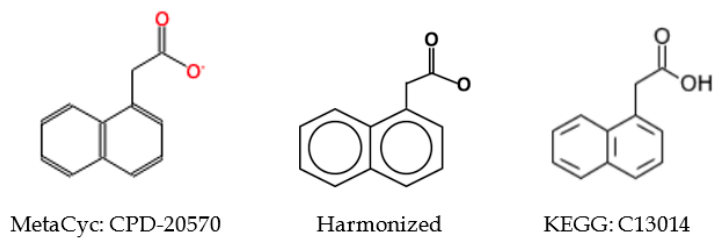
Figure 4. Example of charge inconsistency of compound representations between databases. The middle harmonized compound representation enables loose coloring that facilitates compound harmonization.